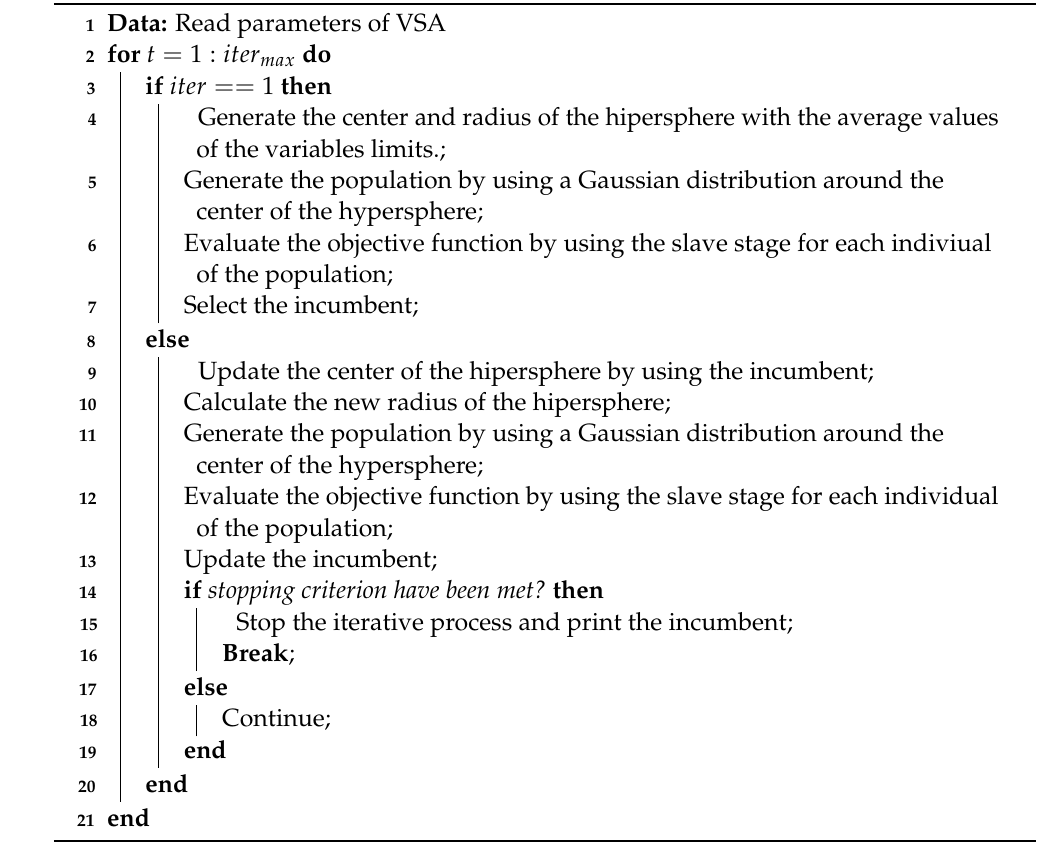
Algorithm 1 Algorithm proposed for the master–slave methodology based on the